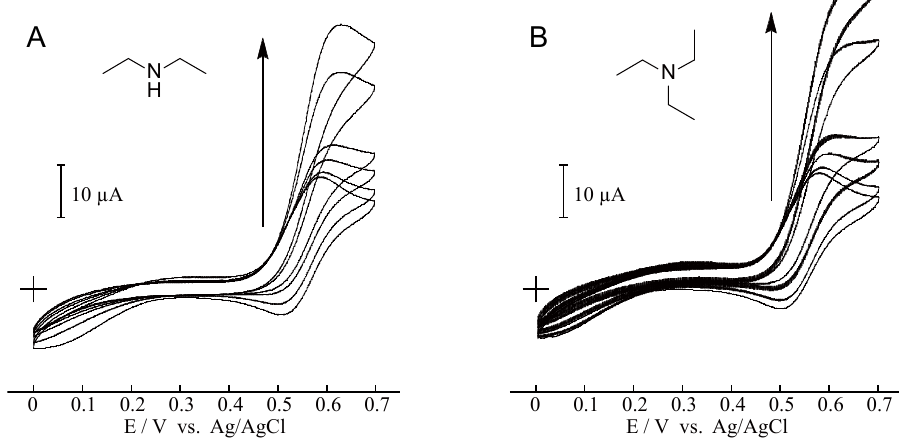
Figure 2. Cyclic voltammograms of NNO (1 mM) in the absence and presence of 1, 5, 10, 50, and 100 mM ( A ) diethylamine and ( B ) triethylamine in 100 mM phosphate buffer solution (pH 7.4). Scan rate was 100 mV s − 1 .